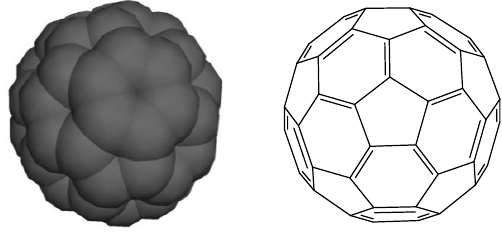
Figure 1. Schematic representation of C 60